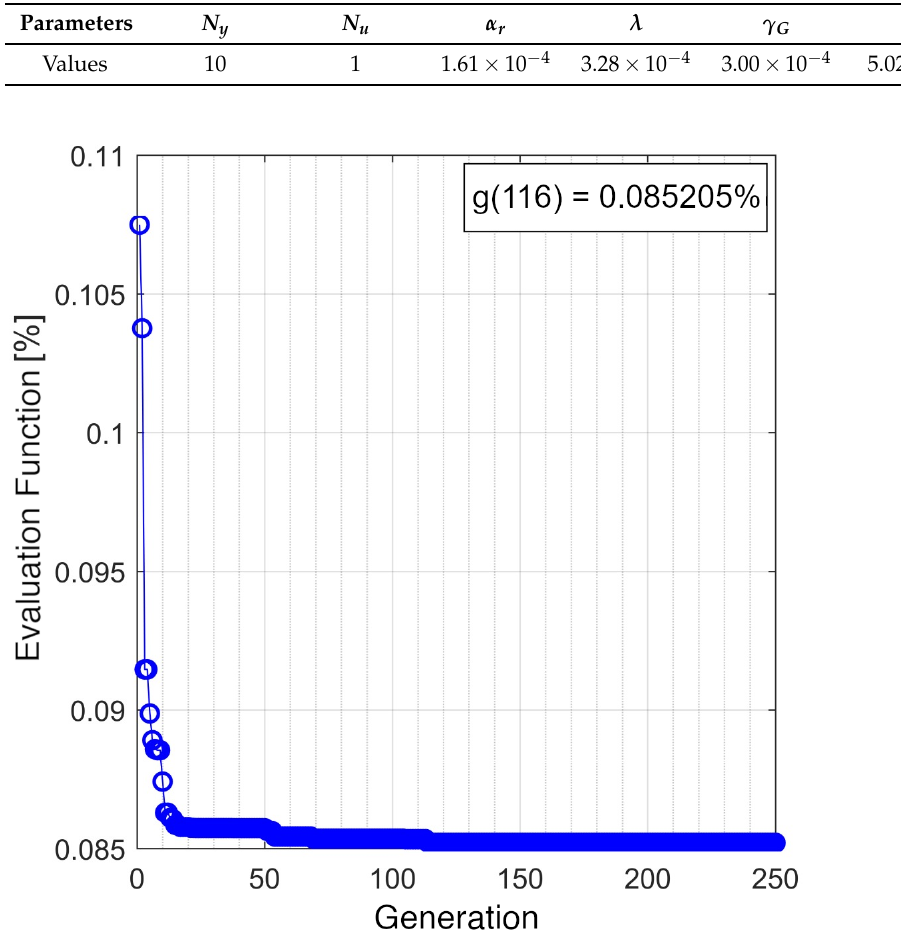
Figure 9. Presentation of the evaluation function values in the optimization process of the Practical Nonlinear Predictive